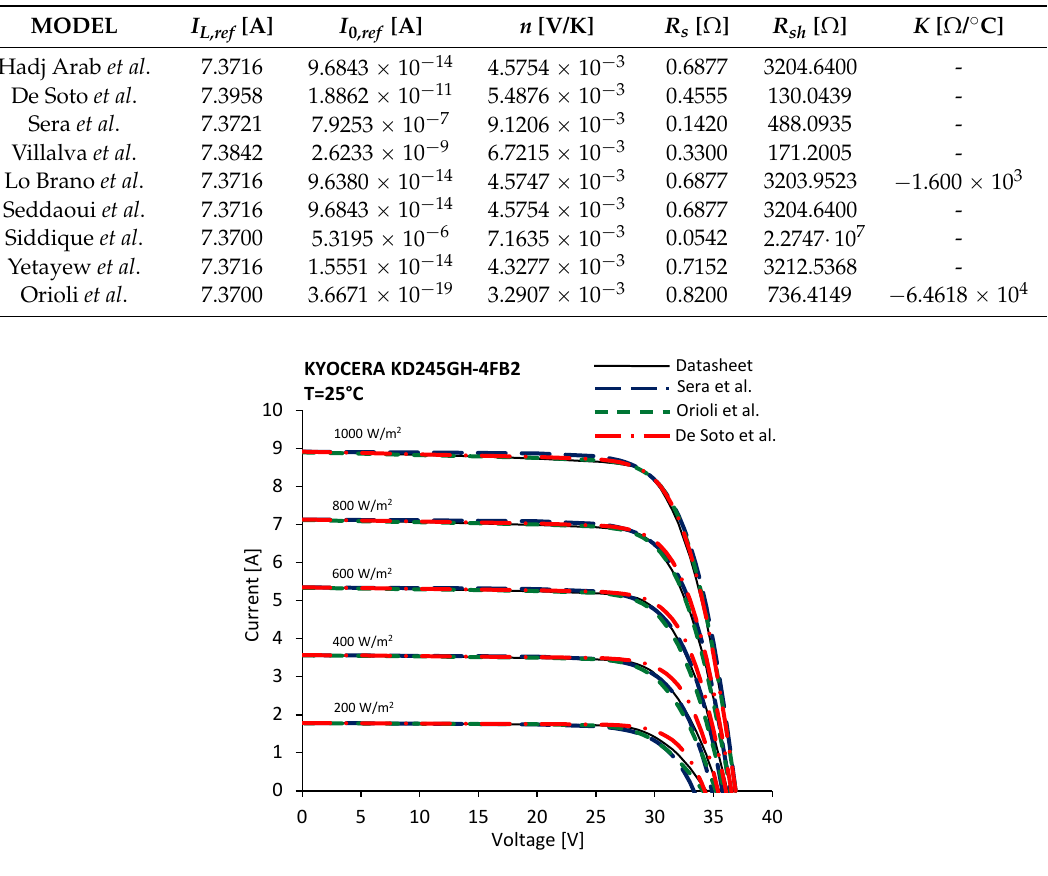
al.Datasheet Villalvaet Yetayew et al. Seddaoui et al.